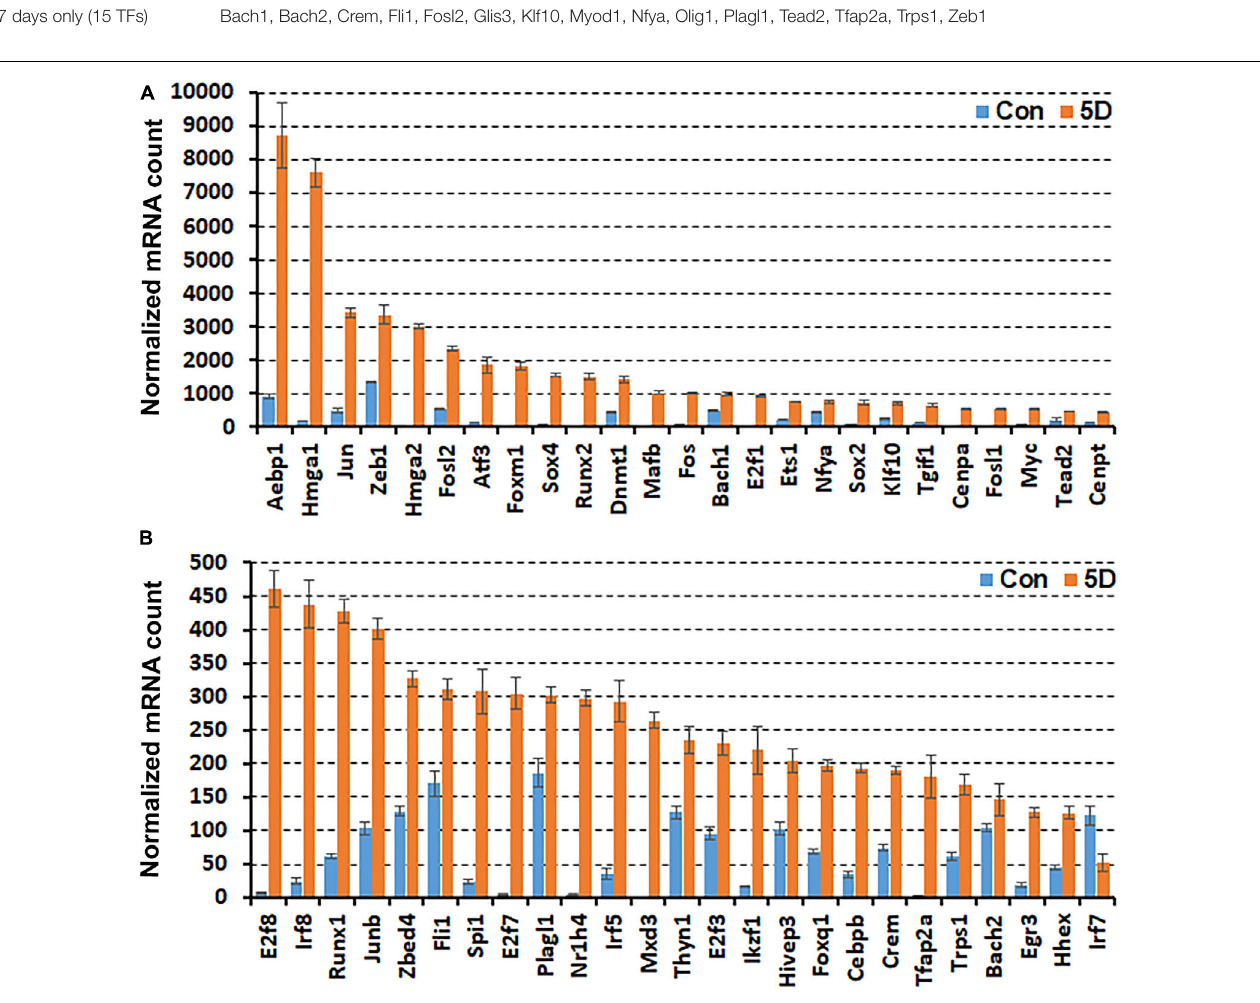
FIGURE 1 | Comparison of normalised mRNA counts for above identified TFs in mouse distal nerve following sciatic nerve crush injury by the analysis of bulk mRNA sequencing data set GSE108231. TFs are arranged according to their normalised mRNA count from highest to lowest in the distal nerve at day 5 post-injury. (A) mRNA counts for TFs bigger than 460 at day 5 post-injury. (B) mRNA counts for TFs smaller than 460 at day 5 post-injury. Con (in blue): control contralateral nerve. 5D (in yellow): distal nerve at 5 day post-crush injury. Glis3, Myod1, Nfe2, Olig1, Tcfl5, and Tfec mRNAs were all undetectable in this data set ( n = 3, all p values <